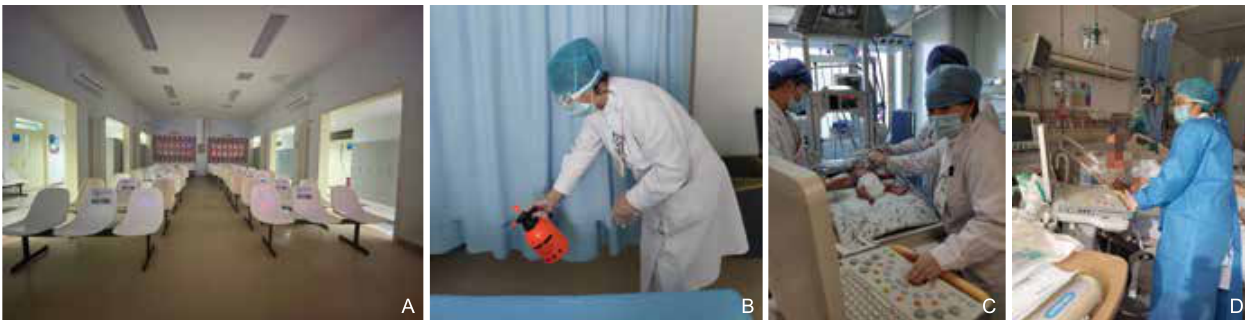
A B C Figure 2 Working environment and protective measures of the ultrasound department. (A) the seats of waiting hall reminded patients to sit at intervals and keep the distance at 1 meter; (B) nurse of ultrasound department was disinfecting the examination room with chlorine disinfectant; (C) bedside ultrasound examination for patients of neonatal ward with first-level protection (wearing work cap, disposable medical surgical mask, disposable gloves, work clothes); (D) ultrasound doctor performed bedside ultrasound examination for ICU patients with second-level protection (wearing disposable work hat, protective glasses, medical protective mask plus surgery mask, disposable impermeable isolation clothing, disposable latex gloves).